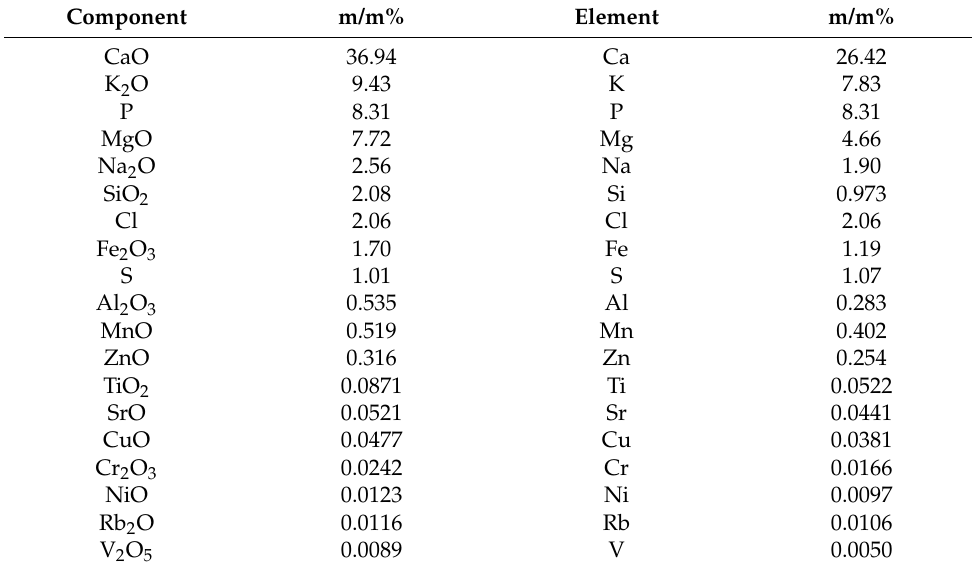
Table 4. Results of manganese sorption by organic material at pH ~ 2. № Fraction,